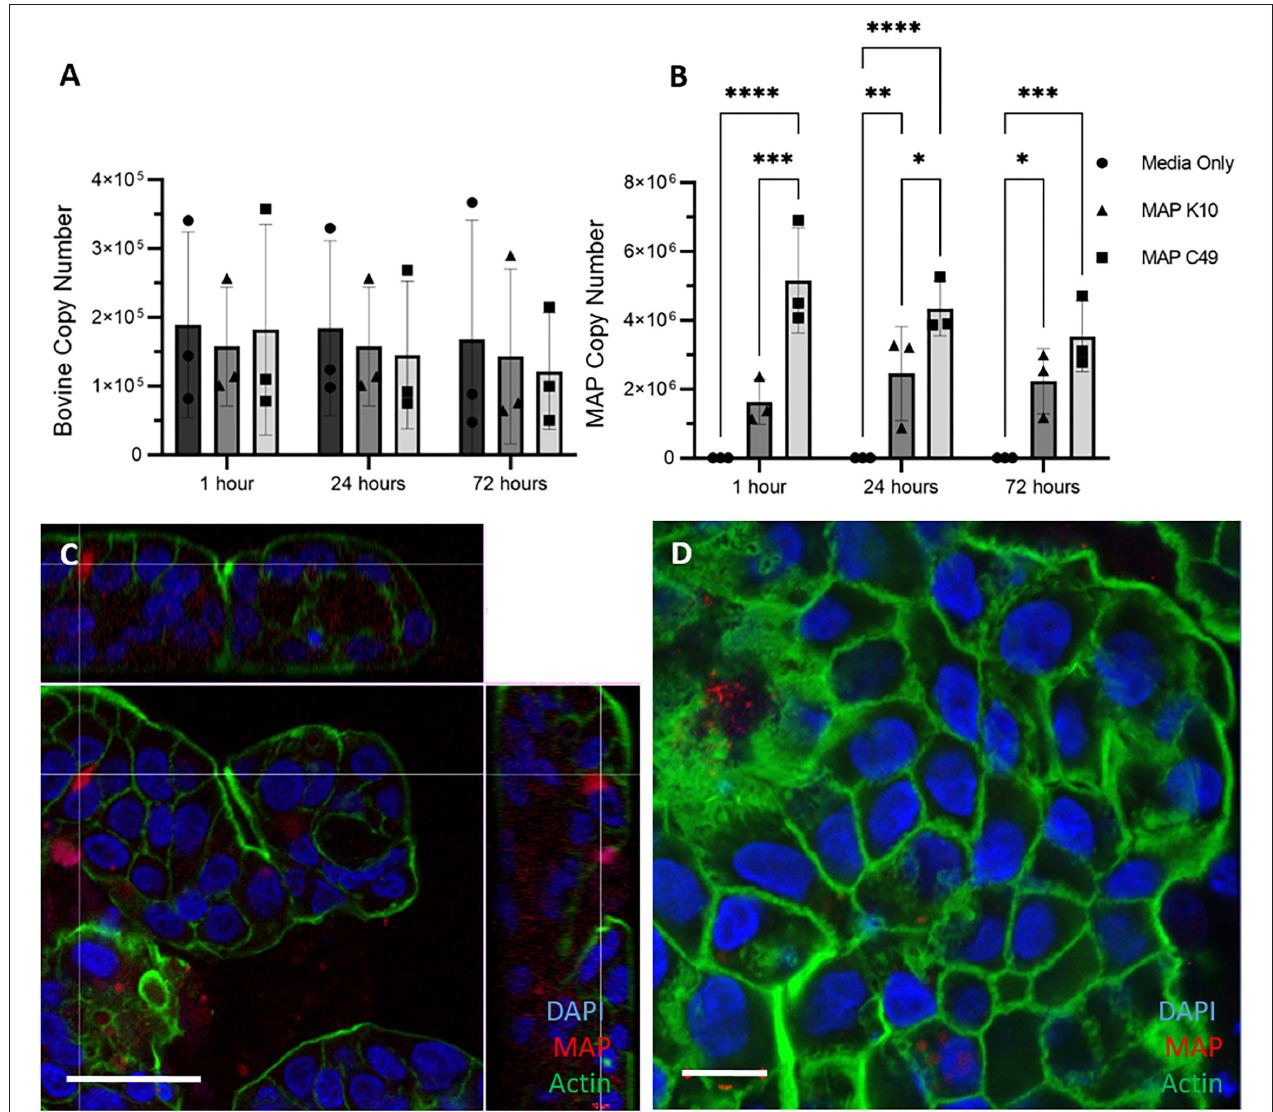
FIGURE 7 | Infection of 3D Apical-out enteroids with 2 different strains of MAP. Apical-out enteroids were infected with an MOI of 100 using apical-out enteroids generated from 3 separate calves. The bovine (A) and bacterial (B) cell number was quantified using qPCR for the spastin gene and F57 sequence element respectively via qPCR (data presented as mean ± SD). Statistical analysis performed using 2-way ANOVA followed by a post hoc Tukey’s test. P < 0.05 = * ; P < 0.01 = ** ; P < 0.001 = *** ; P < 0.0001 = **** . (C,D) Immunofluorescence staining of 3D apical-out enteroids imaged 24h post infection. Slides with infected apical-out enteroids were fixed and stained for nuclei (DAPI, blue), F-actin (Phalloidin, green) and MAP (anti-MAP, red). Apical-out enteroids were infected with MAP K10 (C) and as a cross section from Z-stack images infected with MAP C49 (D) . Scale bar = 10 µ